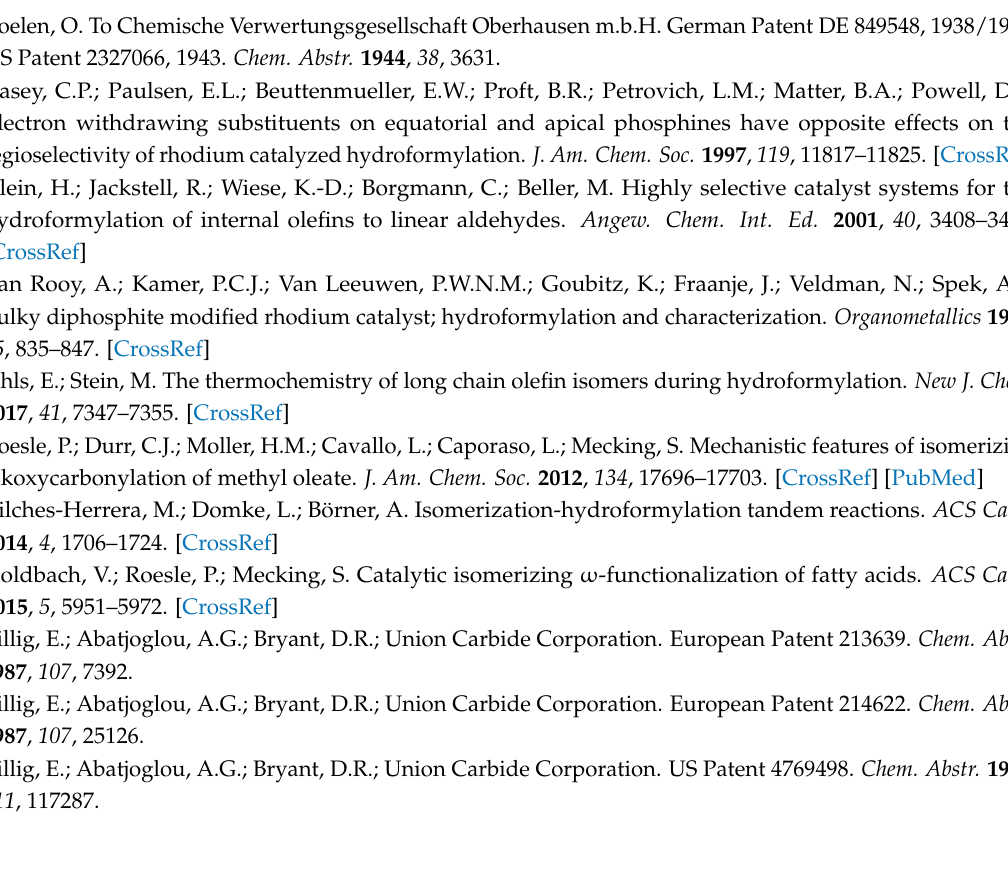
Figure A4. 13 C NMR spectrum (100 MHz, CDCl 3 , 298 K) of a typical final mixture (Table 2, entry 8). Signal of oleonitrile and formed internal olefins ( 1 + 1 ‐ int ) are found at δ 117–137 ppm. Aldehyde signals ( 2 + 3 ) were found at δ 200–205 ppm.